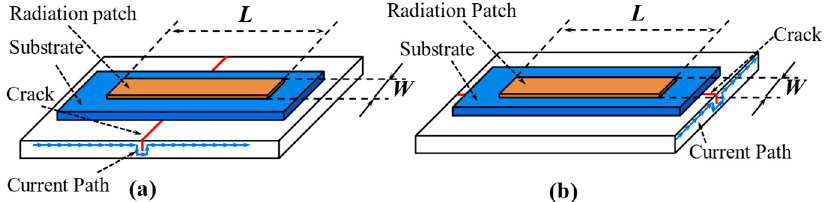
Figure 9. Effects of cracks on current paths. ( a ) a crack parallel to the width of the rectangular patch leads to an increase in current path along the length of the rectangular path. ( b ) a crack parallel to the length of the rectangular patch leads to an increase in current path along the width of the rectangular path.